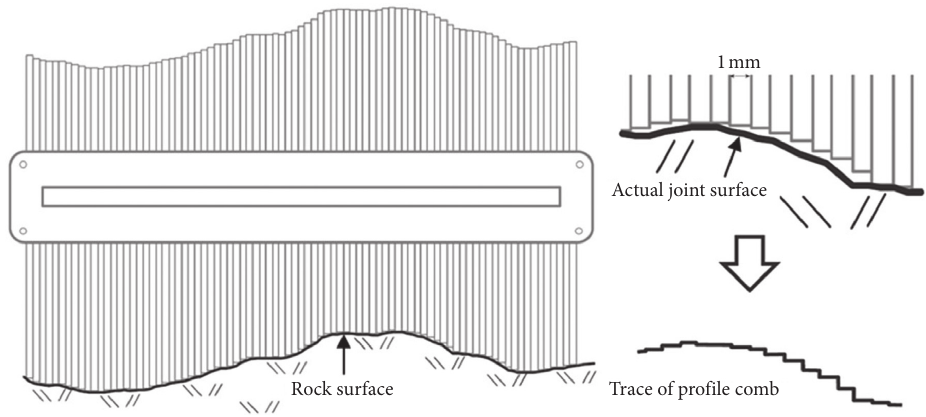
Figure 3: Procedure of using a profile comb to get profile of rock joint